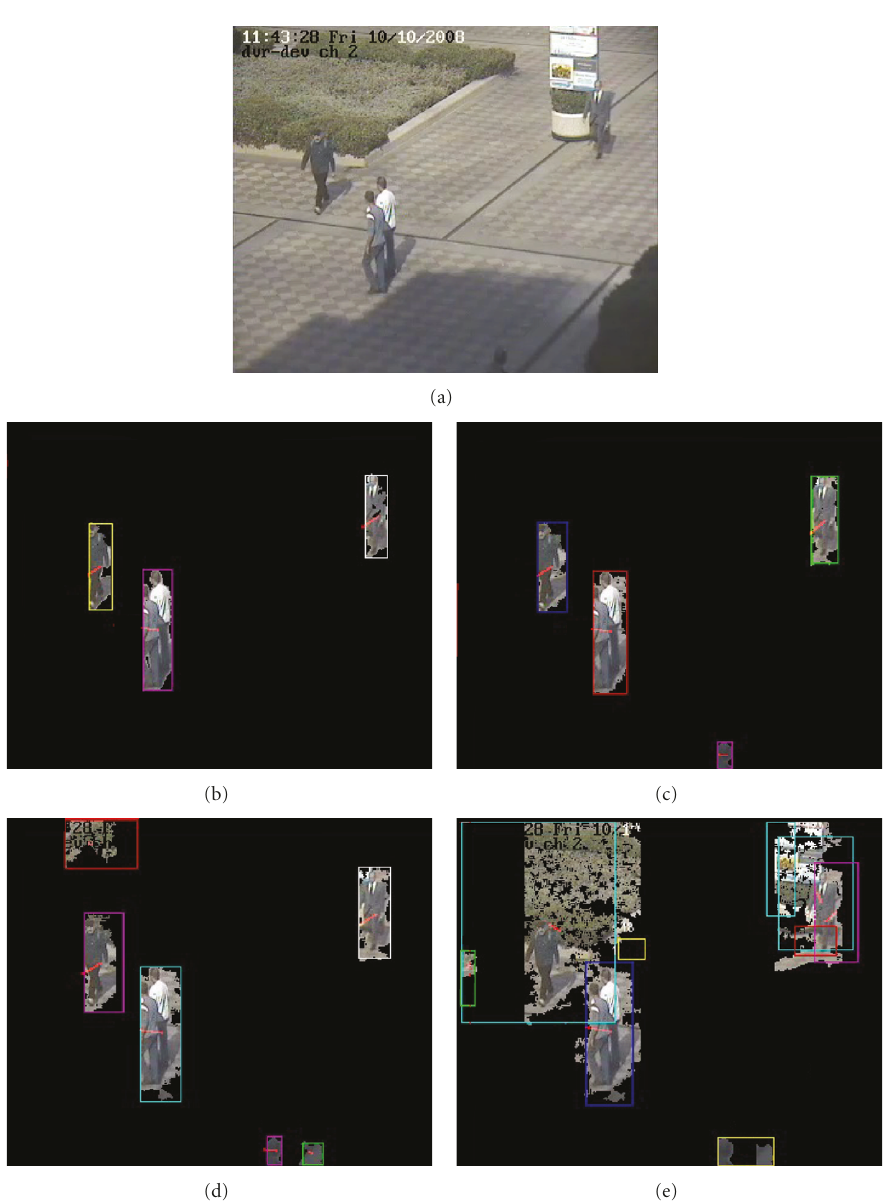
Figure 3: Examples of the output of the foreground detection on the MIVIA1 dataset; (a) Original Image; (b) EBS Algorithm; (c) MOG Algorithm; (d) SOBS Algorithm; (e) SBA